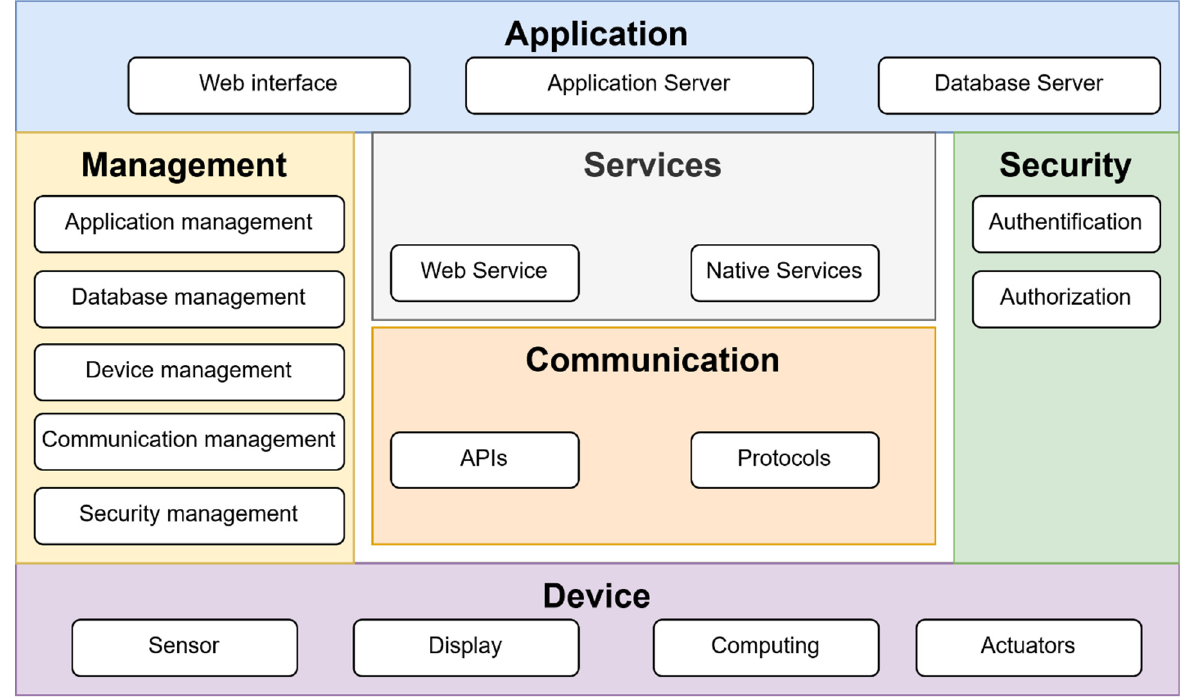
Figure 1. Model of IoT device: functional view specification.